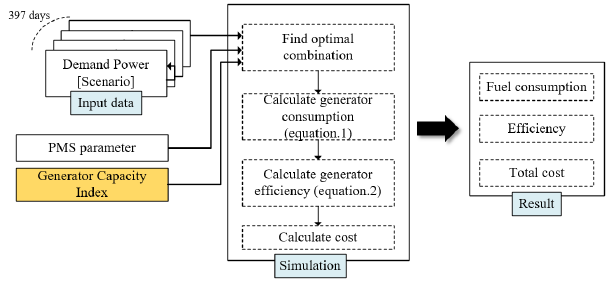
Figure 9. Simulation procedure.